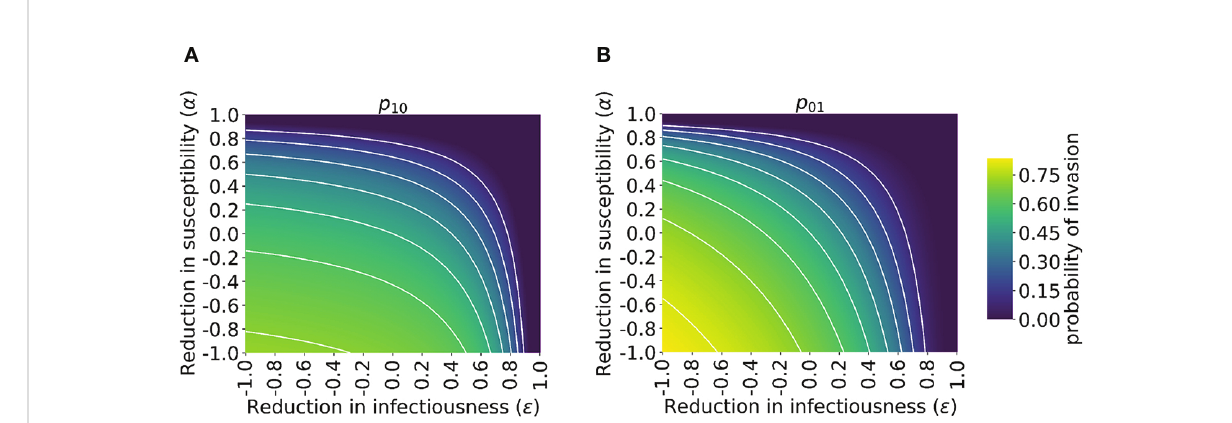
FIGURE 3 Probability of the novel variant invading the host population, starting from the introduction of a single infectious individual, for different levels of cross-reactive immunity affecting susceptibility and infectiousness individually. The invasion probability is approximated analytically by solving system of equations (3) numerically. (A) The probability of the novel variant invading, starting from a single infected individual who was previously immunologically naïve. (B) Analogous to panel A, but starting from a single infected individual who was previously infected by the related virus. White lines represent contours of constant probability of invasion of the novel variant. As in Figure 1, the division of the host population between individuals who were previously immunologically naïve and those who were previously infected by the related virus was calculated based on the fi nal size equation for the previously circulating virus (equation (1)). In this fi gure, R 0 p = 1.5 and R 0 n = 2 (analyses for other values of R 0 p and R 0 n are shown in Figure S4). Other parameter values used are shown in Table